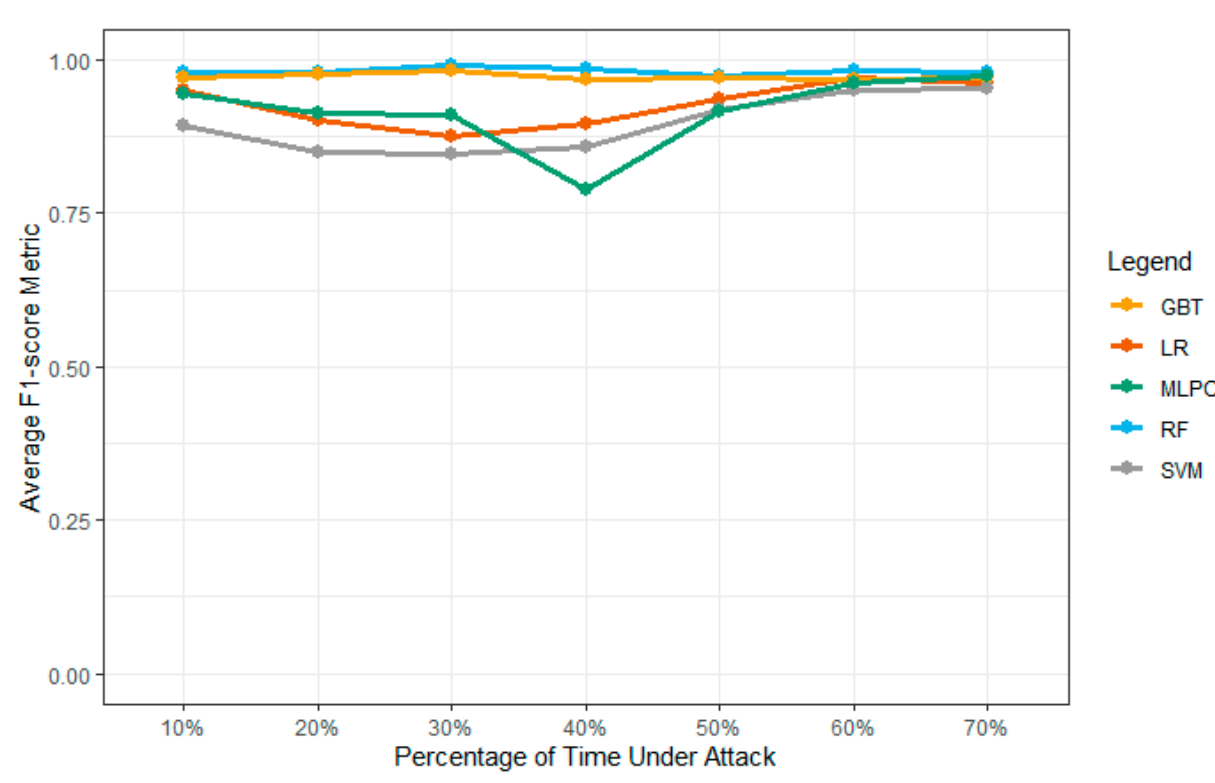
Figure 17. F1 Score values for multiple models for network attacks.